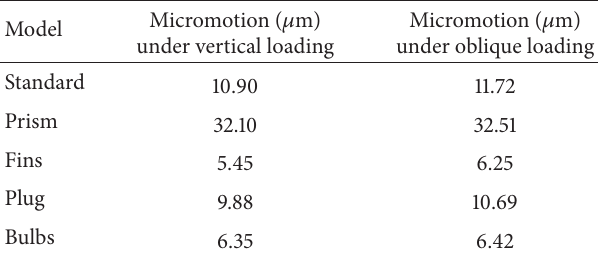
Table 2: Micromotion measures ( 𝜇 m) on the various